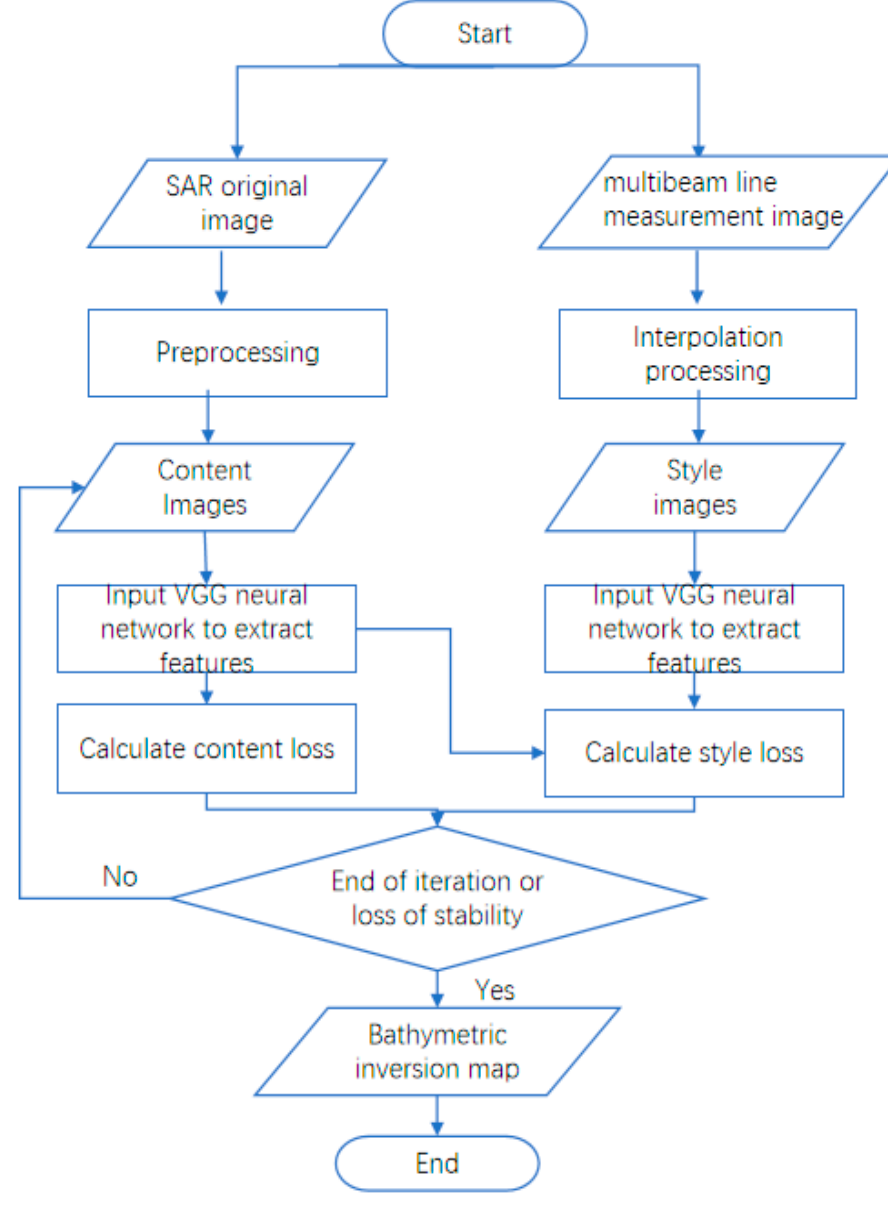
Figure 4. Flowchart of this experiment.